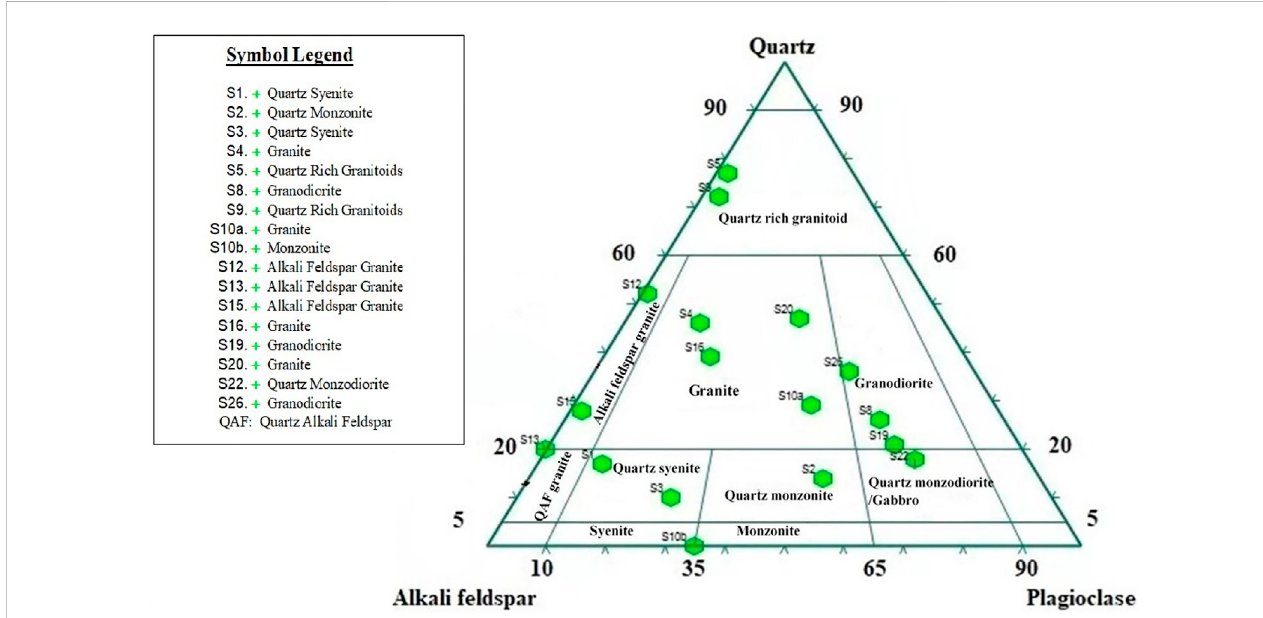
FIGURE 10 Quartz, alkali feldspar, and plagioclase (QAP) model composition of the studied rocks.